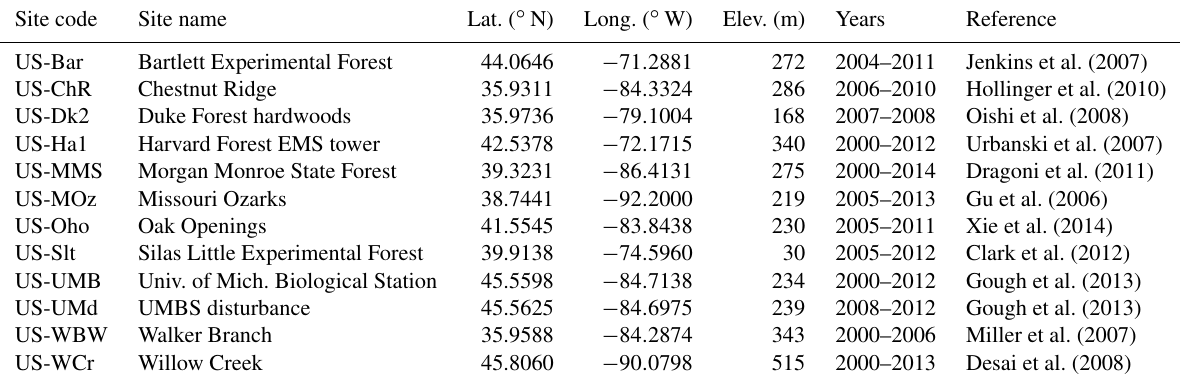
Table 1. Site information for the studied flux towers of deciduous broadleaf